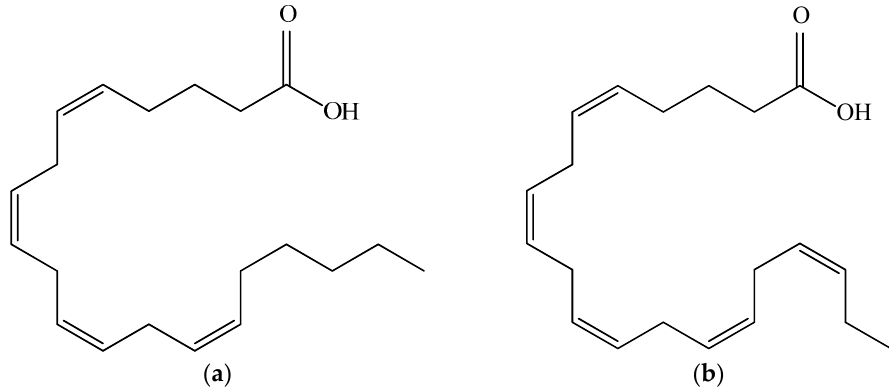
Figure 6. Structural formulas of arachidonic acid ( a ) and eicosapentaenoic acid ( b